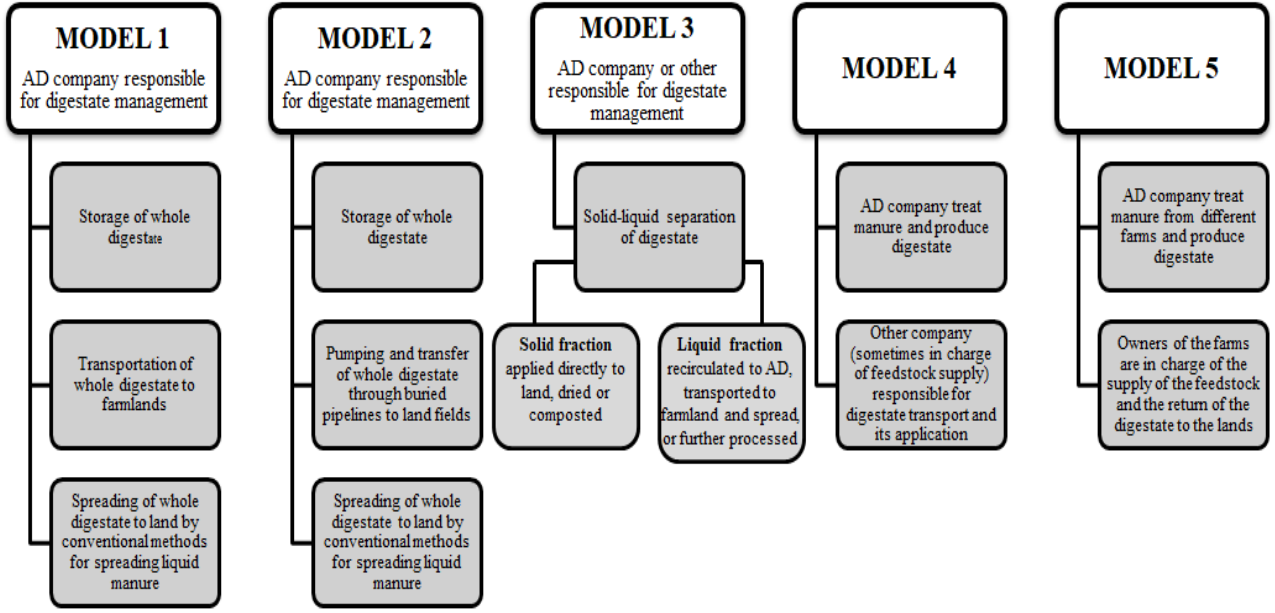
Figure 2. Distribution models of DG (according to [88]).